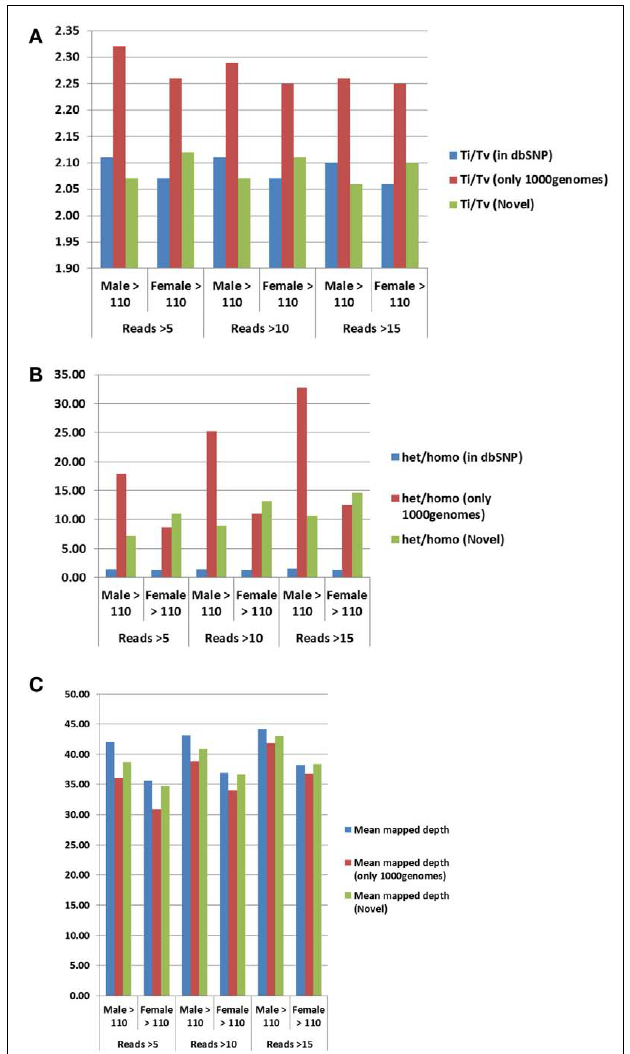
FIGUREA5 |Trends in QC parameters. We evaluated the effect of tighter thresholds on the minimum coverage ( = number of reads) on the transition to transversion ratio (A) , the heterozygous to homozygous ratios (B) and the mean depths (C) .The quality parameters appear to be stable for different thresholds on minimum